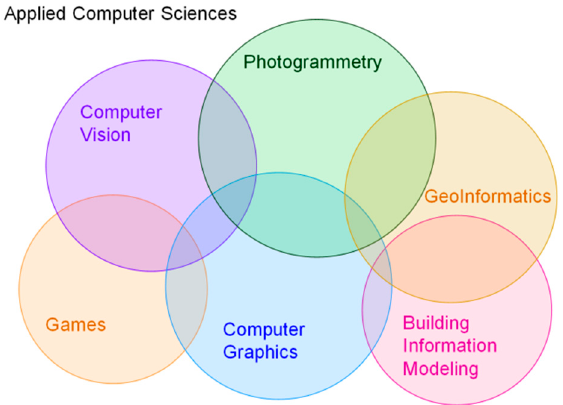
Figure 3. Collaboration of several scientific fields in 2D, 3D and 4D modeling and visualization.